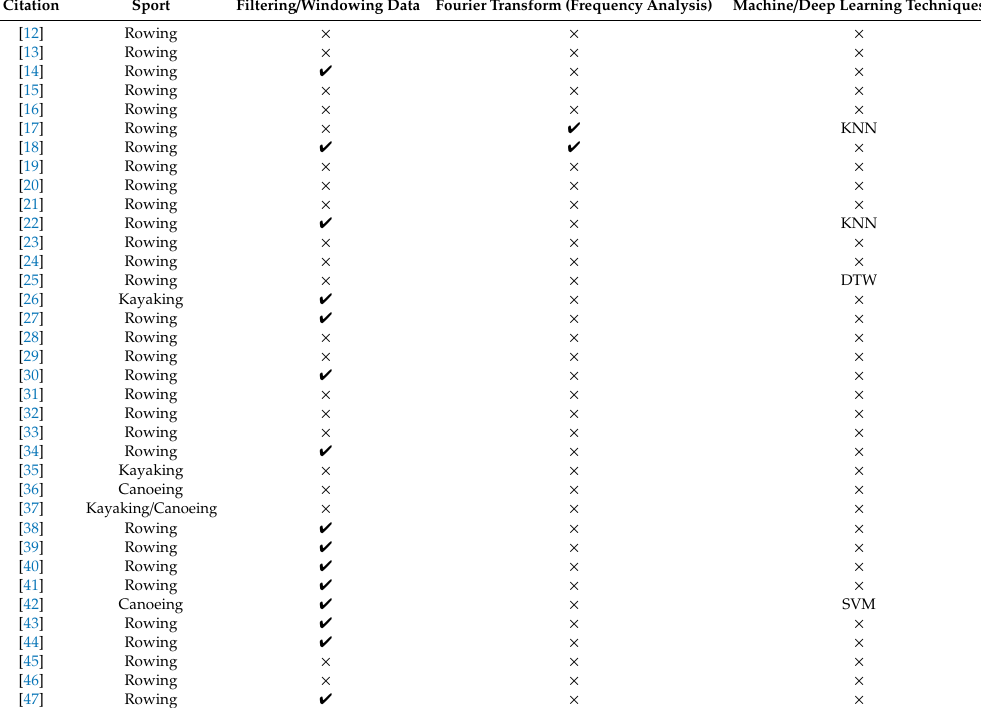
Table 3. Signal processing algorithms used on data, KNN (K-nearest Neighbours); DTW (Dynamic Time Warping); SVM (Support Vector Machine).